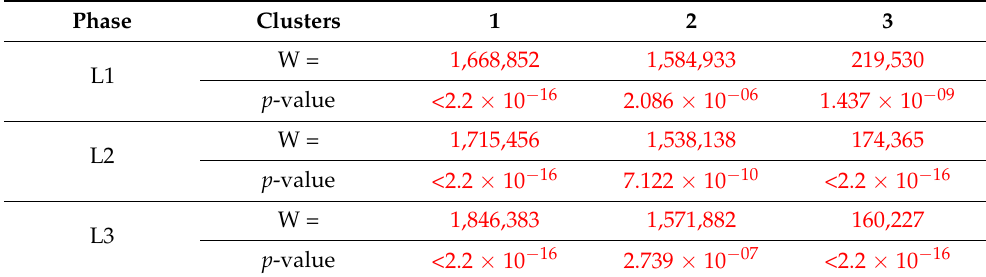
Table 21. Wilcoxon rank-sum test of the THDu ( α = 0.05) in each phase.